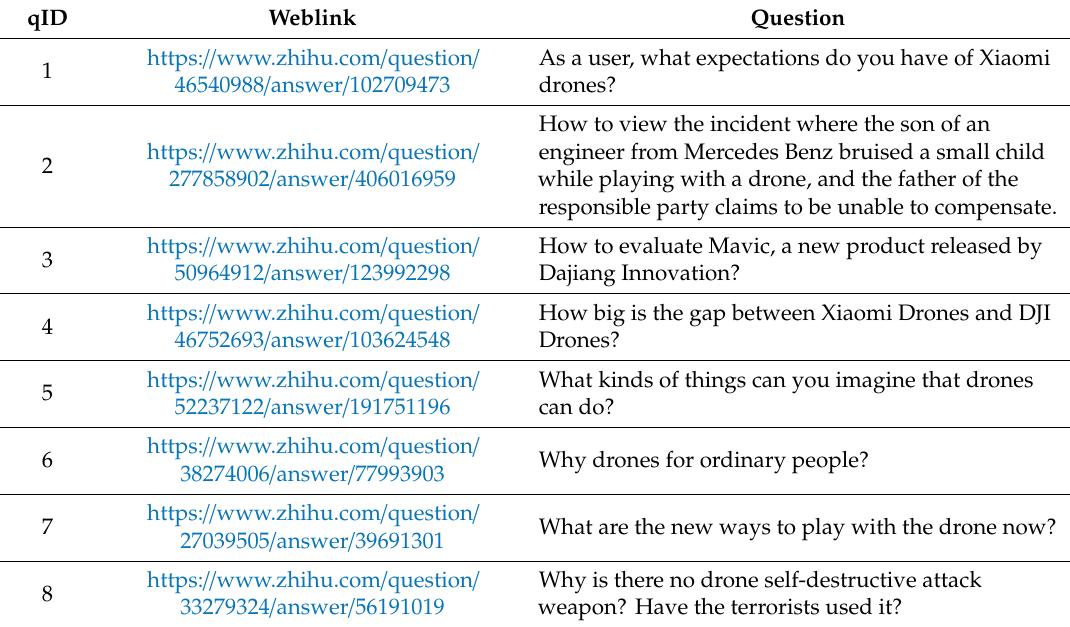
Table A1. The 60 questions 1 with the most endorsed answer in the Drone / UAV topic on